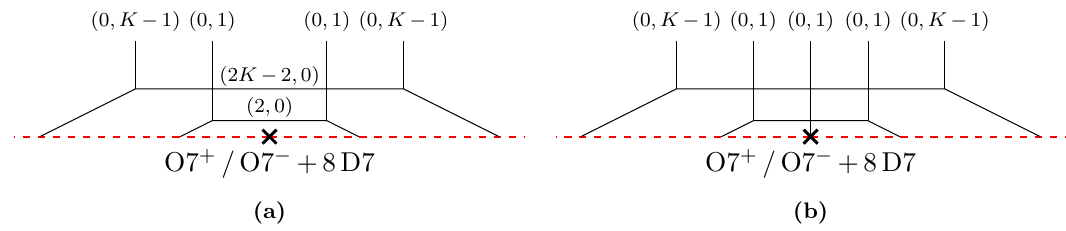
Figure 4. Gauge theory deformations of I (cid:6) for j = 4 and N = 2 K even on the left, and N;j with a fractional NS5, N = 2 K + 1 odd, on the right. After decoupling the quiver tails by moving the (0 ; K (cid:0) 1) branes to in(cid:12)nity, the remaining central nodes correspond to gauge theories discussed in [27]. For N even and an O7 + , it is SO(2 N ) with 2 N (cid:0) 4 hypermultiplets in the vector representation, for an O7 (cid:0) with 8 D7 it is USp(2 N ) with 2 N +4 fundamental hypermultiplets. For N odd and an O7 + the central node is SU(2 N (cid:0) 2) with one symmetric and 2 N (cid:0) 6 fundamental hypermultiplets, for an O7 (cid:0) with 8 D7 it is SU(2 N (cid:0) 2) with one antisymmetric and 2 N + 2 fundamental hypermultiplets. Leaving the (0 ; K (cid:0) 1) branes in the picture and separating them horizontally gives the full quiver gauge